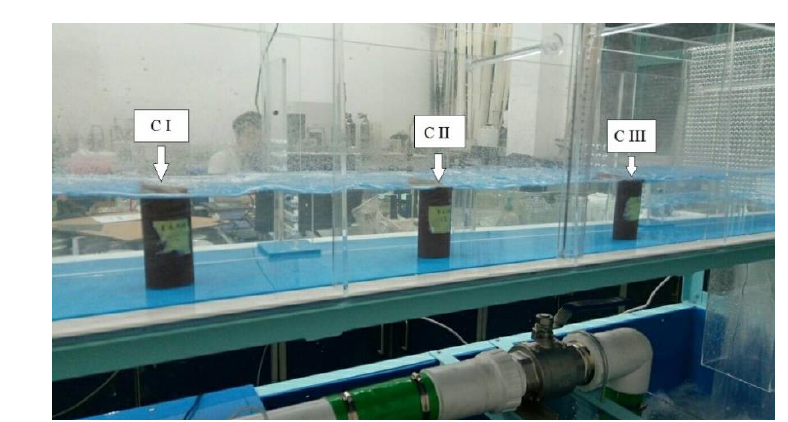
Figure 3. Sample chart.